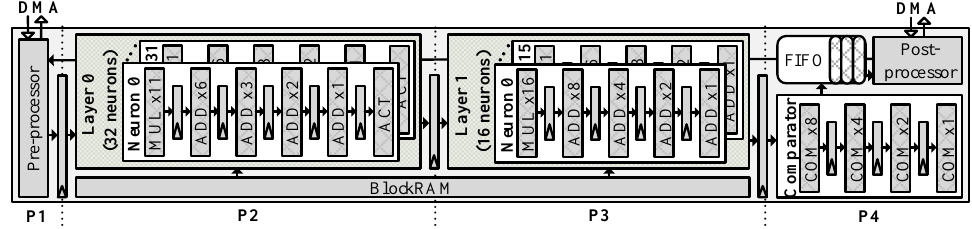
Figure 5. Pipeline implementation of the Neuron Network Architecture block on an FPGA-based architecture includes four phases: Input buffering (P1), Layer_0 calculation (P2), Layer_1 calculation (P3), and Output buffering